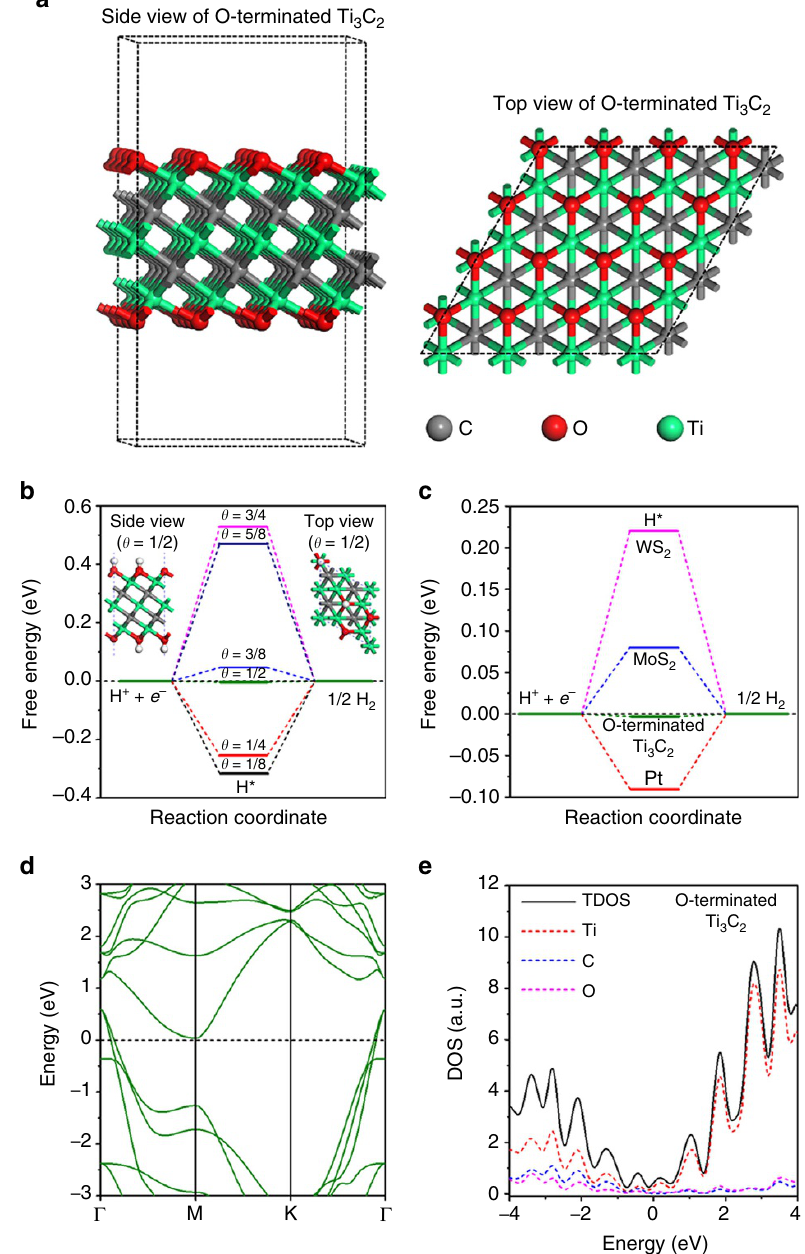
Figure 1 | Density function theory calculation studies of O-terminated Ti 3 C 2 . ( a ) The side and top views of the structure model for a 4 (cid:3) 4 (cid:3) 1 O-terminated Ti 3 C 2 supercell. Grey, red and cyan spheres denote C, O and Ti atoms, respectively. ( b ) The calculated free-energy diagram of HER at the equilibrium potential ( U ¼ 0V) on the surface of a 2 (cid:3) 2 (cid:3) 1 O-terminated Ti 3 C 2 supercell at different H* coverage (1/8, 1/4, 3/8, 1/2, 5/8 and 3/4) conditions (the side and top views of a 2 (cid:3) 2 (cid:3) 1 O-terminated Ti 3 C 2 supercell at 1/2 H* coverage are shown in the inset). ( c ) The calculated free-energy diagram of HER at the equilibrium potential (U ¼ 0V) on the surface of a 2 (cid:3) 2 (cid:3) 1 O-terminated Ti 3 C 2 supercell at 1/2 H* coverage, and the referenced Pt (ref. 21,22) MoS 2 (ref. 23), and WS 2 (ref. 23). ( d ) The calculated band structure of O-terminated Ti 3 C 2 . ( e ) The total density of states (TDOS) and partial density of states (PDOS) for O-terminated Ti 3 C 2